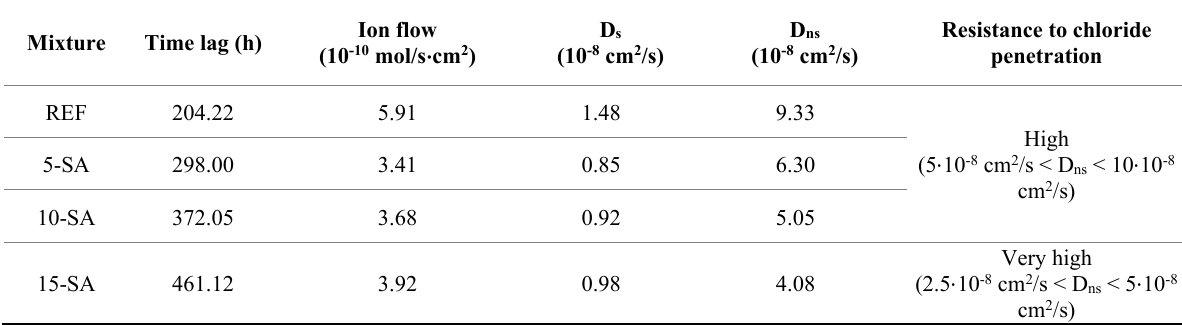
Table 4. Classification of concretes with different silica fume contents as to resistance to chloride penetration, according to the limits established by Nilsson et al. [44].